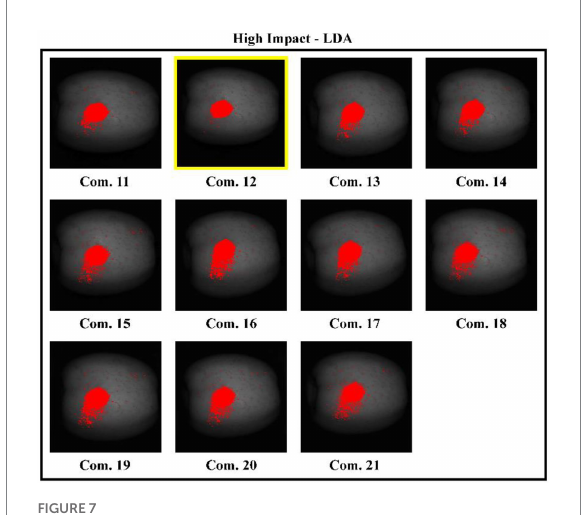
FIGURE 7 LDA classification result images using various wavelength resolutions, for apples with high-impact level bruises. Combination 12 (boxed in yellow) was found to be the best wavelength resolution for detecting bruises.